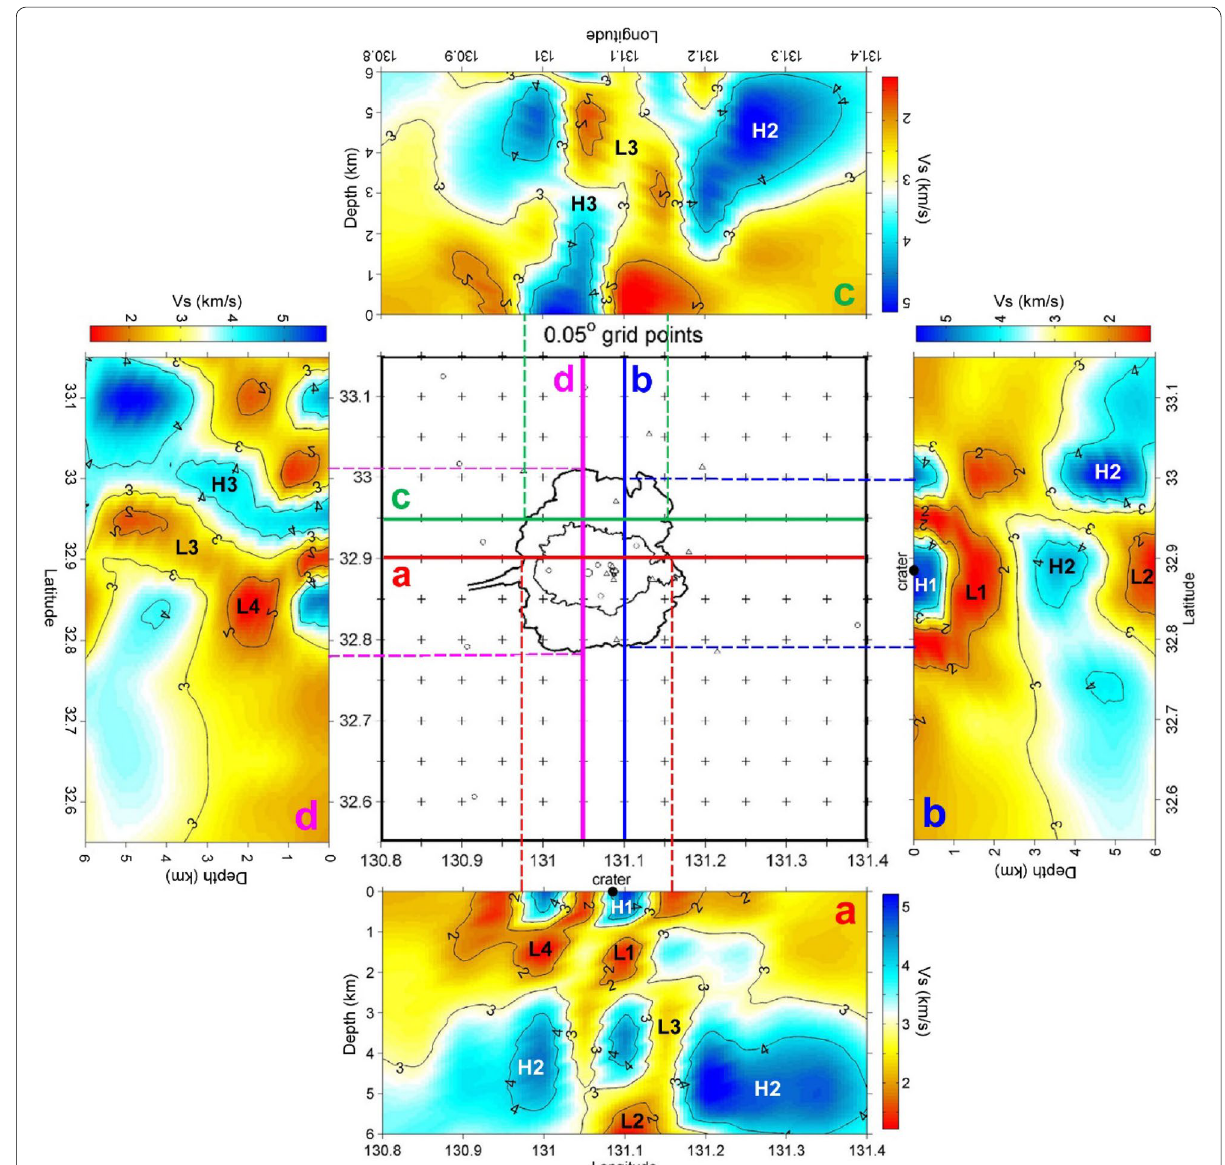
Fig. 14 Four V s profiles transect Aso caldera at depth of 6 km: a 32.9°N across the Nakadake crater; b 131.1°E across the Nakadake crater; c 32.95°N across the northern part of the caldera; and d 131.05°E across post‑caldera central cones near Kusasenrigahama. Dashed lines mark the profile boundaries of Aso caldera, and crosses mark the locations of 0.05° grid points. H1–H3 and L1–L4 are the identified velocity